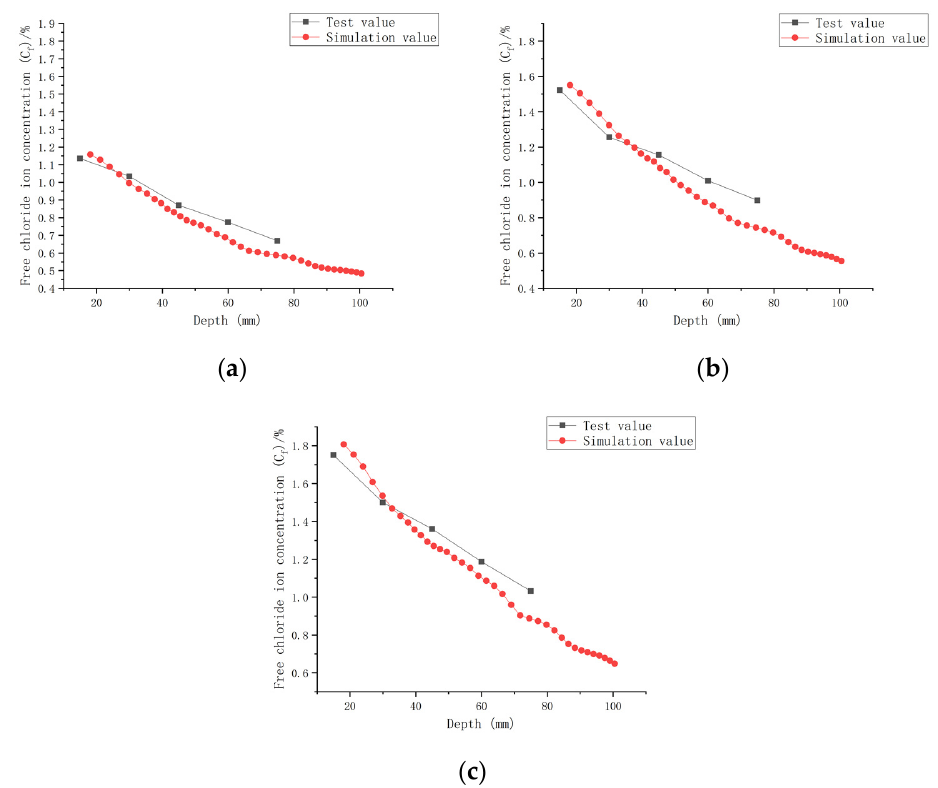
Figure 14. Relationship between C f and depth (W/C = 0.35). ( a ) Load is 0; ( b ) load is 0.1; ( c ) load is 0.2.